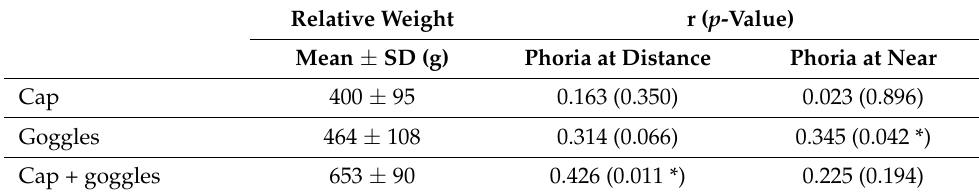
Table 6. Pearson’s correlation coefficient between phoria and the relative weight loaded.